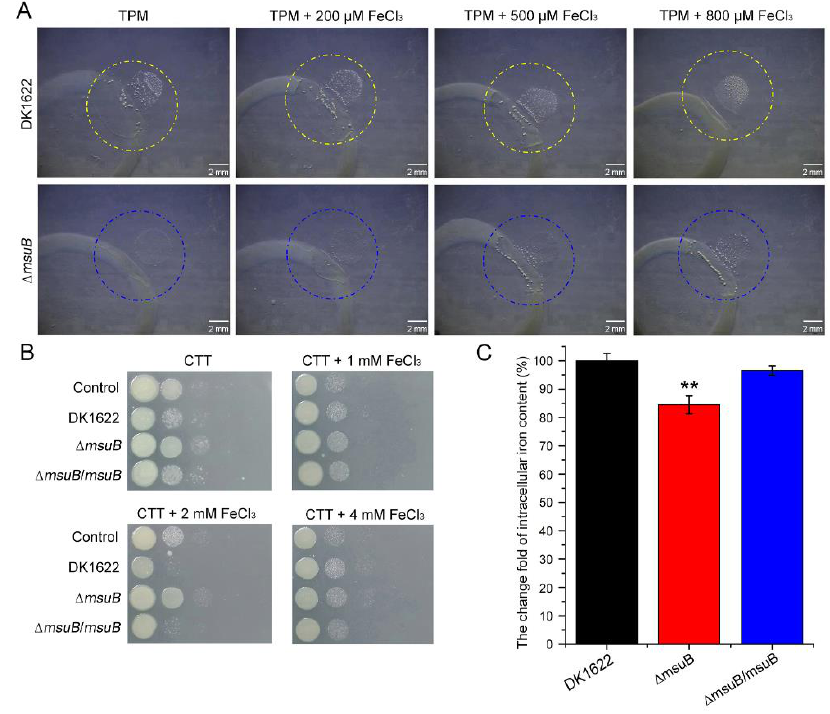
Figure 2. Differences in predation ability between DK1622 and ∆ msuB mutants under different iron concentrations. ( A ) The effects of different iron concentrations on myxobacterial predation on TPM (1.5% agar) plates were assessed by a predation experiment. Scale bars = 2 mm. ( B ) The survival of P. aeruginosa co- cultured with DK1622, ∆ msuB , and ∆ msuB/msuB at different iron concentrations for 24 h was calculated by a competitive experiment. The cocultured M. xanthus strains and PAO1 were harvested and the cells were resuspended in 1 mL of MMC buffer. Subsequently, the cellular sus- pension was serially diluted in MMC buffer. Next, 3 µL of the suspensions (from 10 −2 to 10 −6 ) was spotted on LB agar plates supplemented with tetracycline (20 µg mL −1 ) from left to right. The plates were grown at 37 °C and photographed after 24 h. ( C ) The relative content of intracellular iron was detected by the BPS method. ** p -value <0.01 compared with the DK1622 as measured by a two- tailed unpaired Student’s t -test.